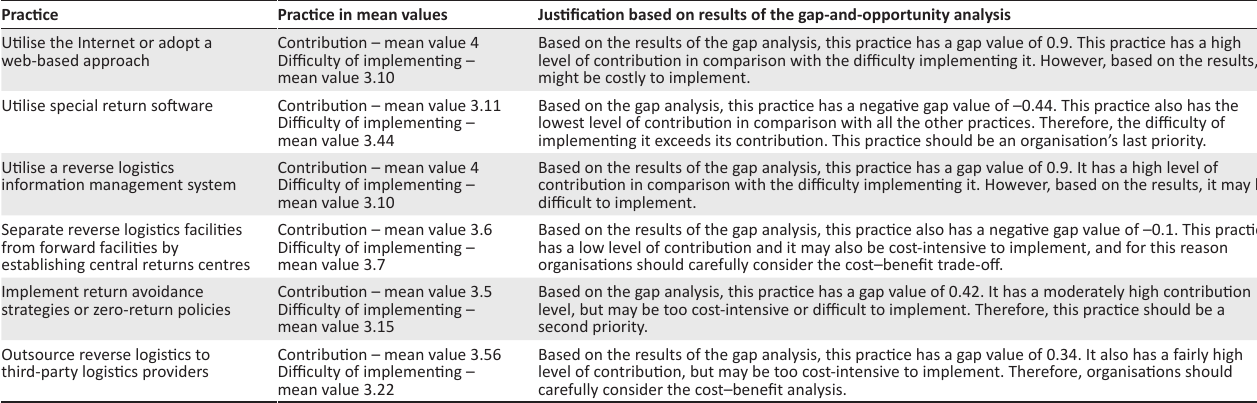
TABLE 4: Reverse logistics practices in the Oyster quadrant – second priority. Practice Practice in mean